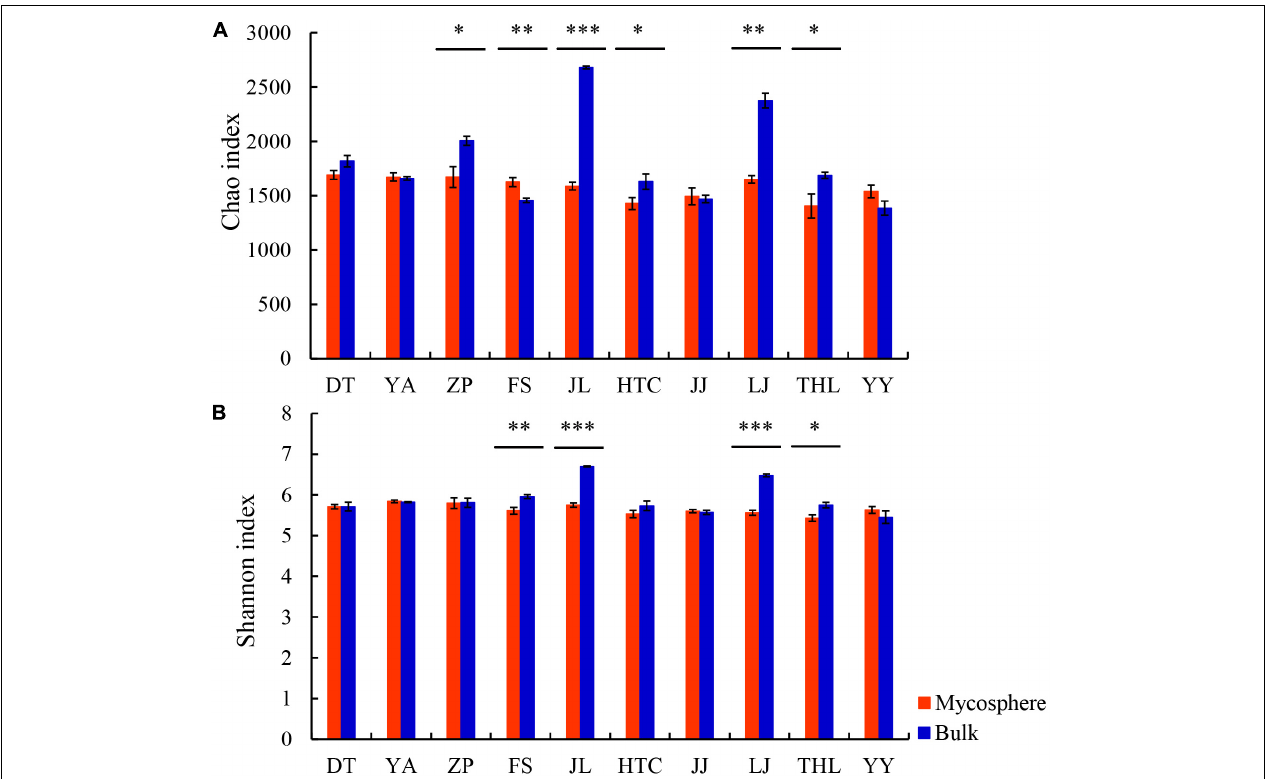
FIGURE 2 | Comparison of Chao (A) and Shannon (B) indexes between mycosphere and bulk soil. Significant differences by * p < 0.05; ** p < 0.01 and *** p < 0.001.